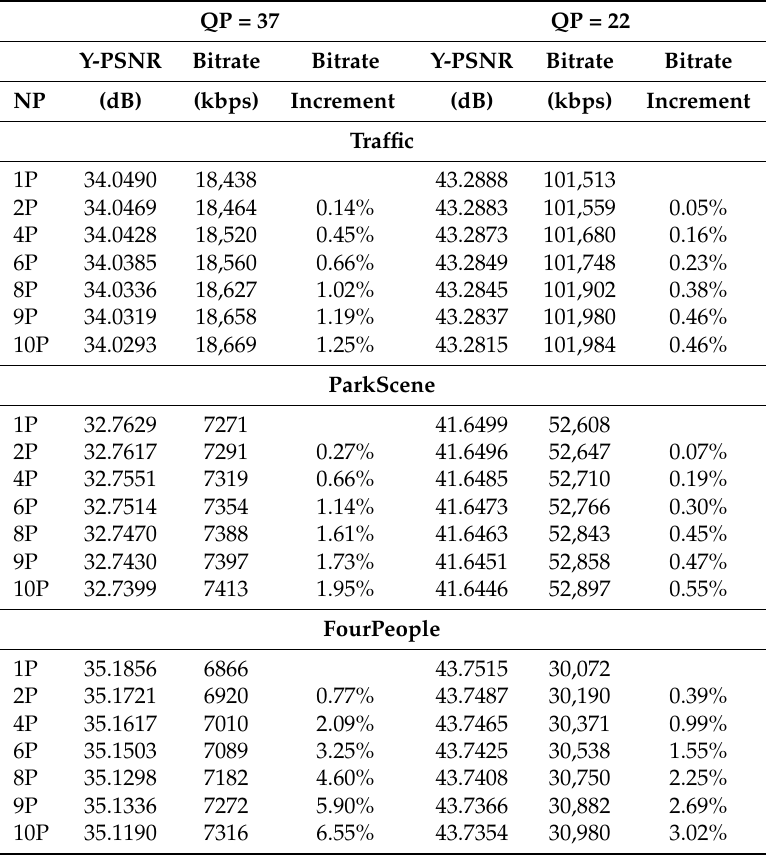
Table 4. Coding performance of the slice-based parallel